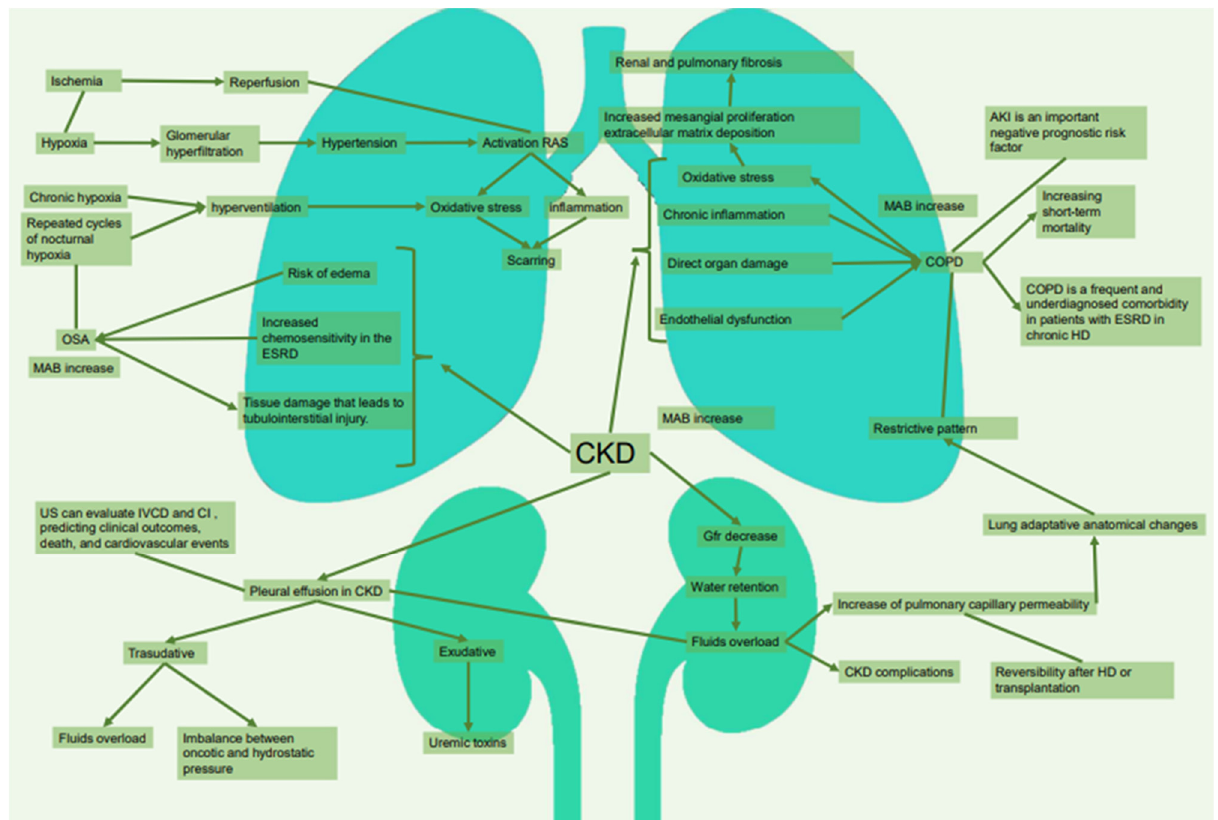
Figure 1. Pulmonary complications related to CKD. CKD: chronic kidney disease. RAS: renin- angiotensin System. OSA: obstructive sleep apnoea. ESRD: end-stage renal disease. IVCD: inferior vena cava diameter. CI: collapsibility index. GFR: glomerular filtration rate. HD: hemodialysis. COPD: chronic obstructive pulmonary disease. AKI: acute kidney injury. MAB: microalbuminuria.